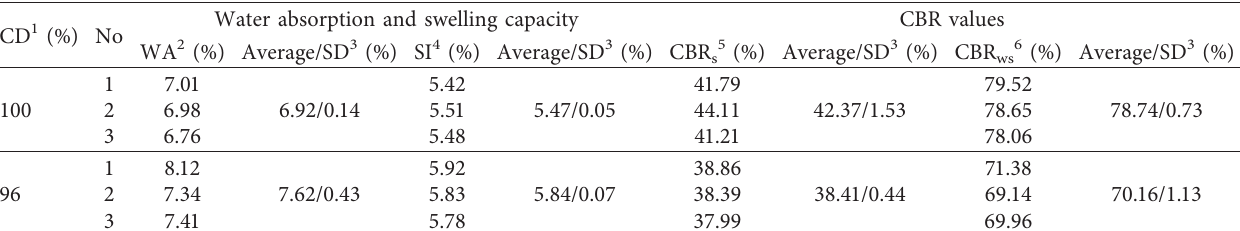
Table 1: Results of CBR test.